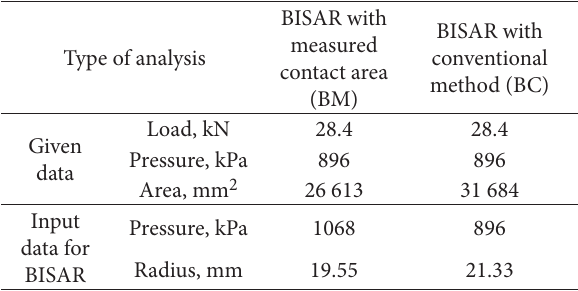
Table 1. Summary of input data for BM and BC analysis